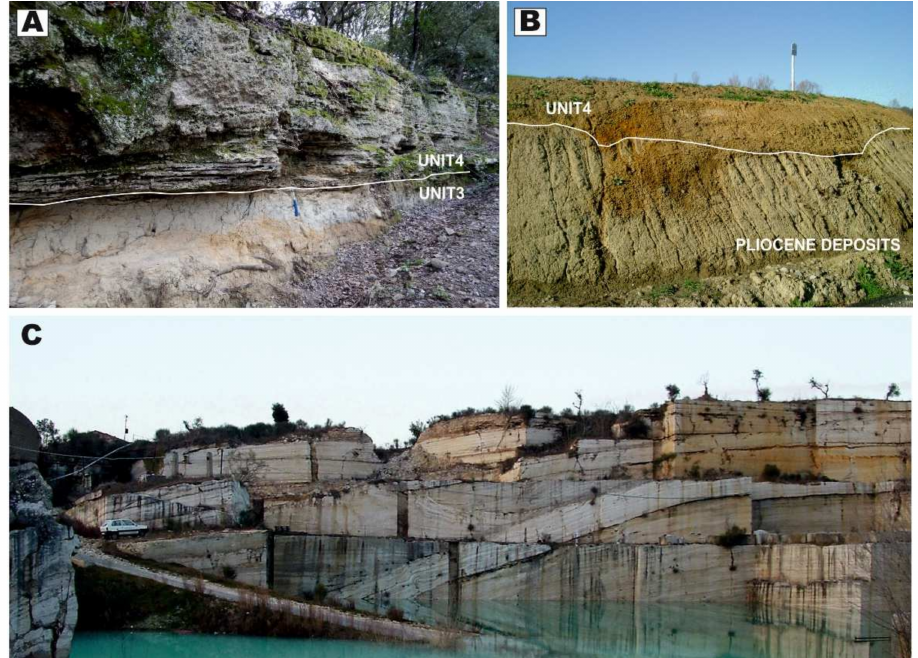
Figure 15. Deposits of Units 3 and 4. ( A ) Travertine of Unit 3 unconformably overlying lacustrine sand of Unit 3. ( B ) Fluvial terraces of the Ombrone River (Unit 4) covering Pliocene marine mud. ( C ) Travertines of Unit 4 in the Rapolano